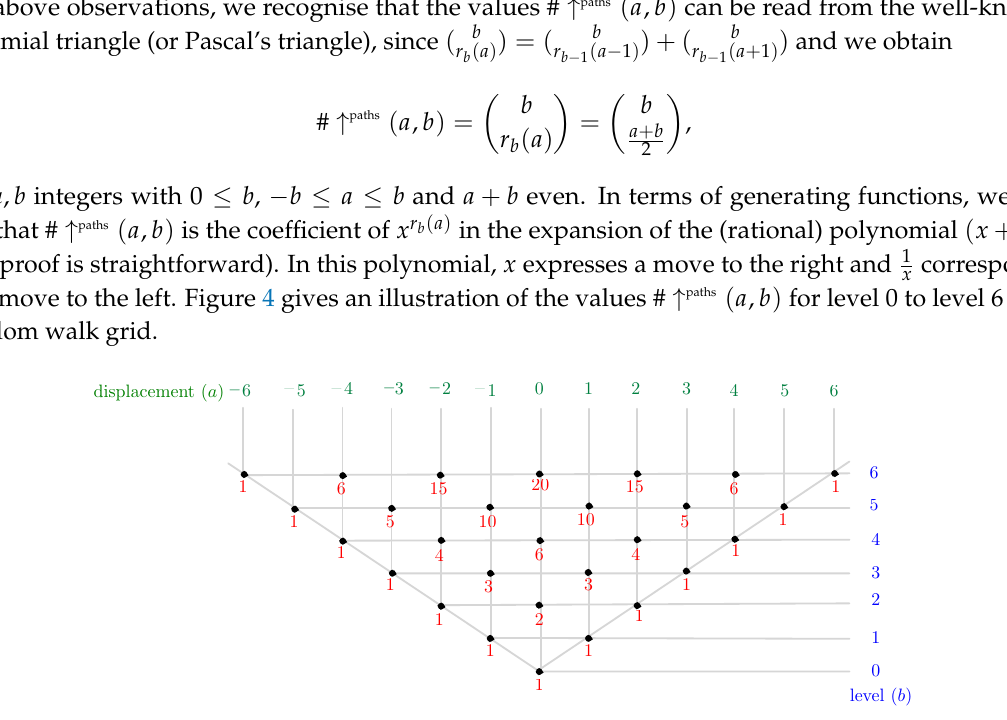
Figure 4. The local grid on the bottom cone with the numbers #